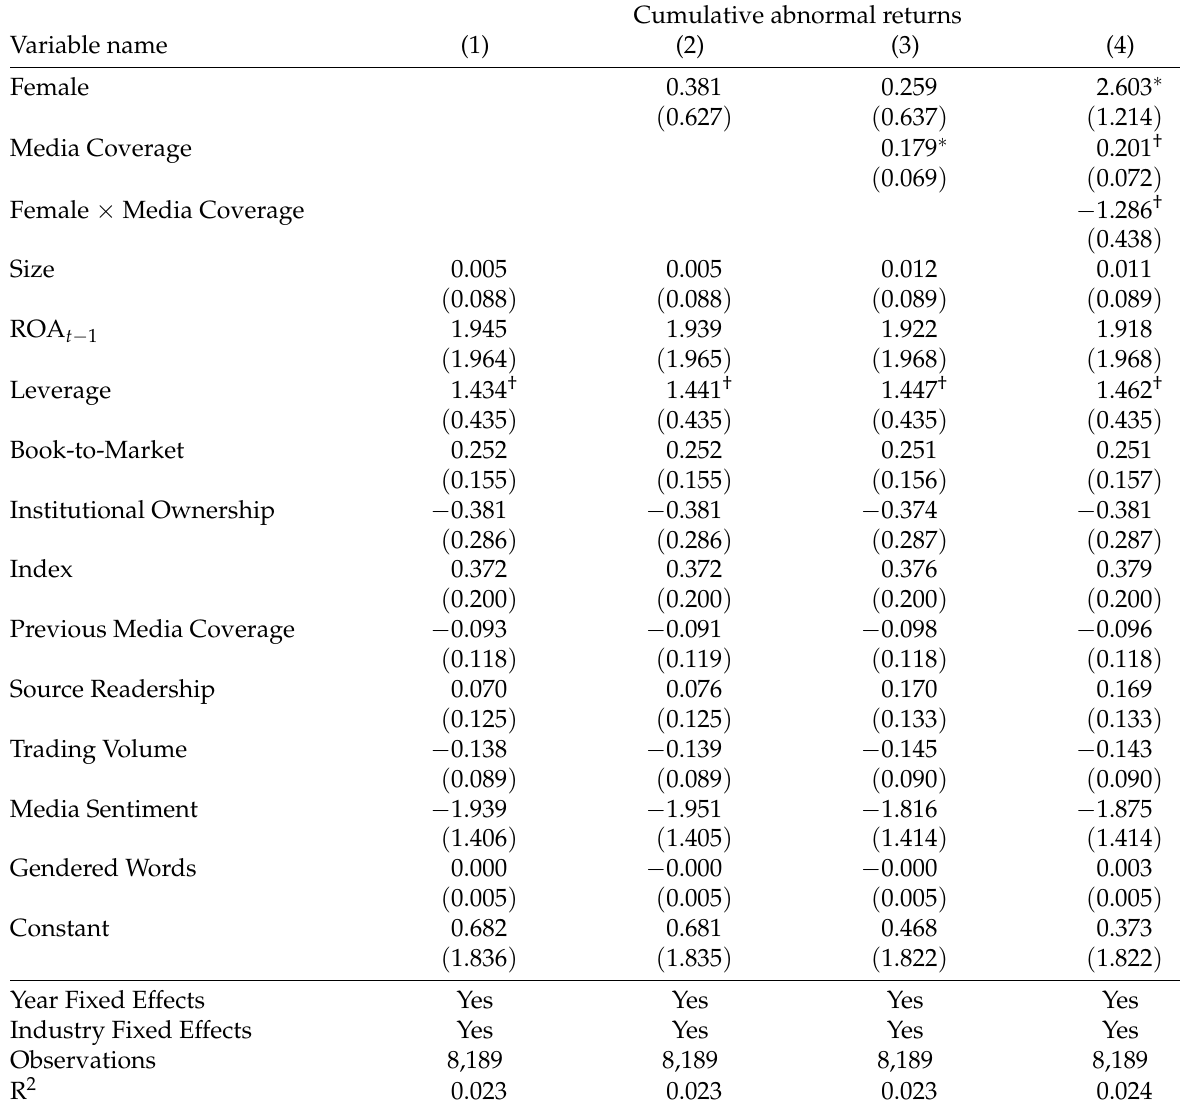
Table 4: Ordinary least squares regressions of media coverage and CEO gender on cumulative abnormal